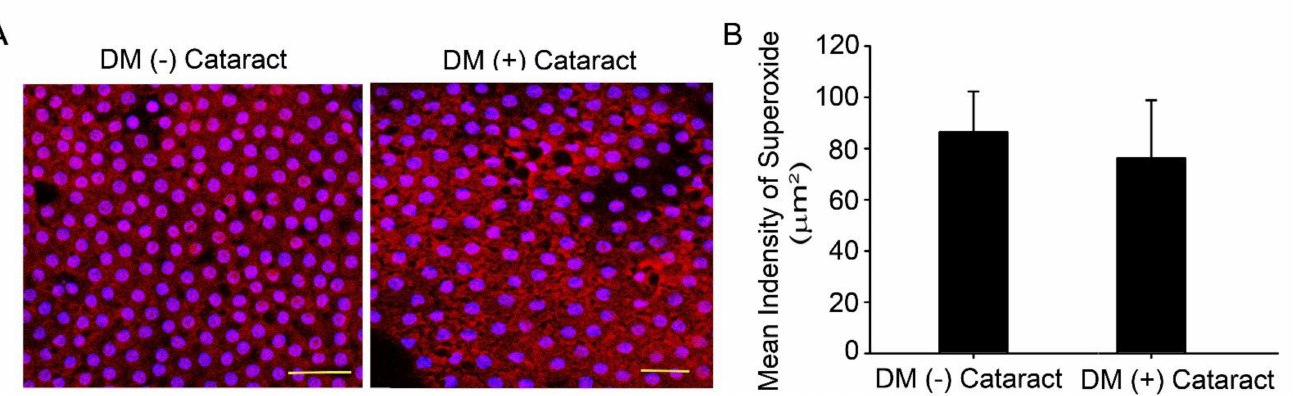
Figure 1. Superoxide generated in the lens of cataract in diabetic patients. ( A ) Representative images showing superoxide-positive cells in red, lens epithelial tissue was derived from cataracts of diabetic or non − diabetic patients. Cell nuclei were counterstained with DAPI (blue). Scale bar = 20 µ m. ( B ) Quantified values (right) are represented as mean ± SEM ( n = 10 for each